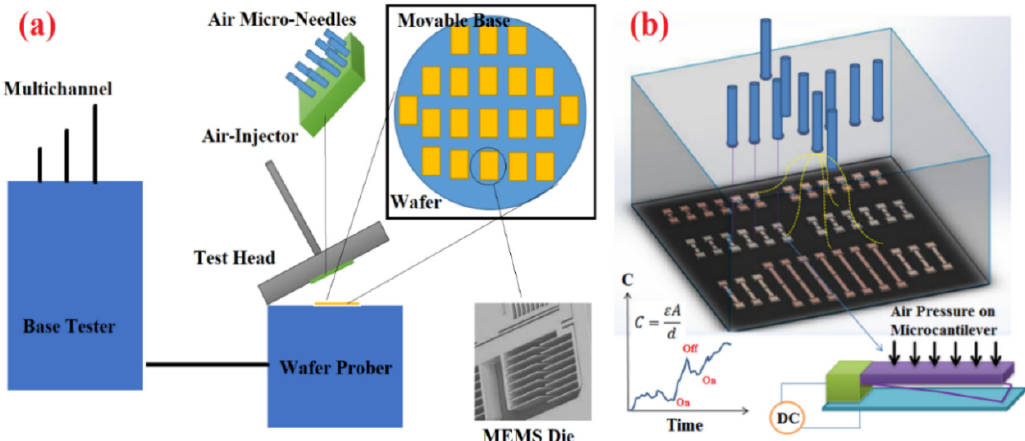
Figure 3. Airflow-based Force Manipulation representation for MEMS sensor characterization and testing. ( a ) The DUT schematics of AbFM. ( b ) The working principles of AbFM for microcantilevers. All components of an ATE system is shown in (a); the air-injector is the essential component of this device that should be designed at the component design of MEMS devices. At the component design level, a fluid–solid interaction analysis will be done to design the microneedles (for directing airflow) size and location on top of the MEMS die. (b) Demonstrates the AbFM system for testing the functionality of microcantilever MEMS die that includes 74 microcantilevers, modeled the same as the placement in real fabricated MEMS device.